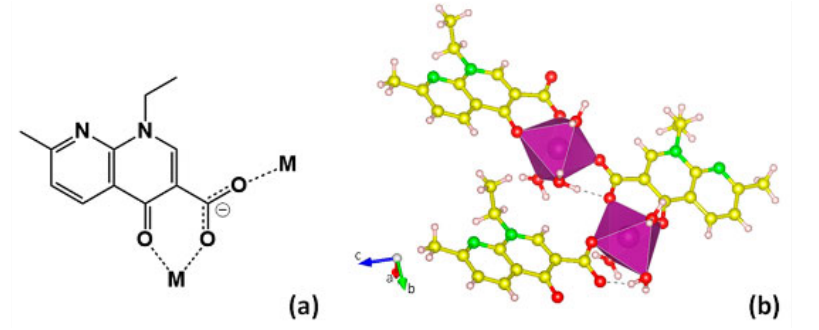
Figure 9. ( a ) Coordination modes of nalidixic acid in the MOF is shown ( b ) The octahedral geometry of the coordination spheres of metal centres are shown. Reproduced with permission from [74] .